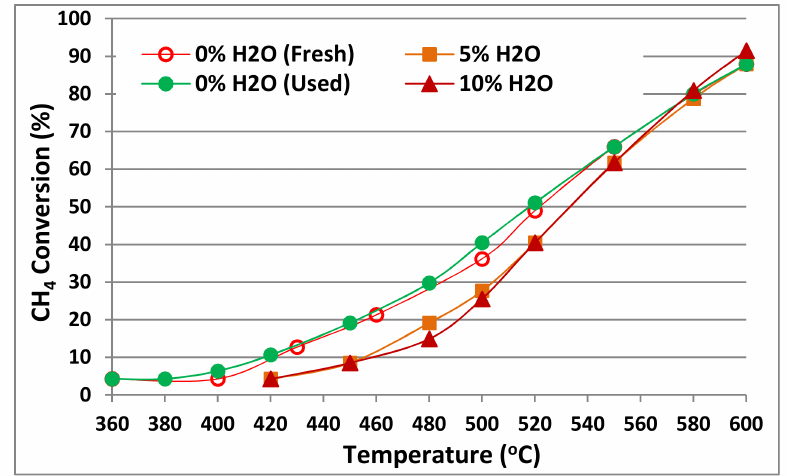
Figure 8. CH 4 catalytic combustion over 15Co/CeO 2 -H (fresh and used) with different contents of water vapor addition (0, 5 and 10 wt%). Flow rate: 900 cm 3 /min; GHSV~40,000 h − 1